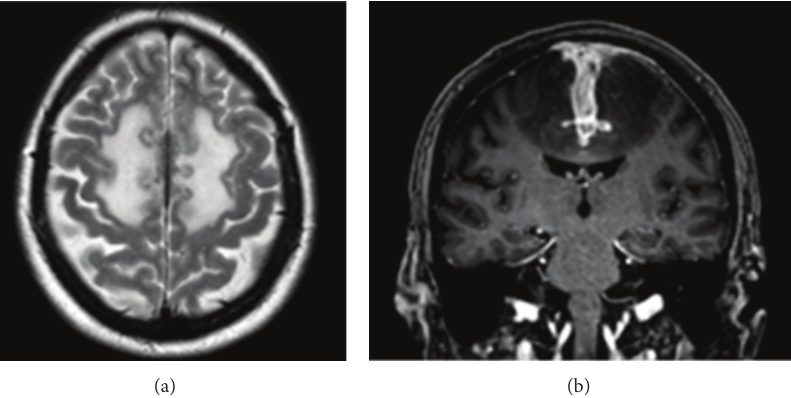
Figure 3: Imaging 9 months after presentation, following 10 cycles of IV cyclophosphamide therapy (05/2013). (a) Axial T2 demonstrates progressive parafalcine oedema, mass effect, and subtle cortical haemorrhage. (b) Coronal T1 postcontrast image demonstrates progressive avid leptomeningeal enhancement, cortical swelling, and avid enhancement of progressively thickened dura.